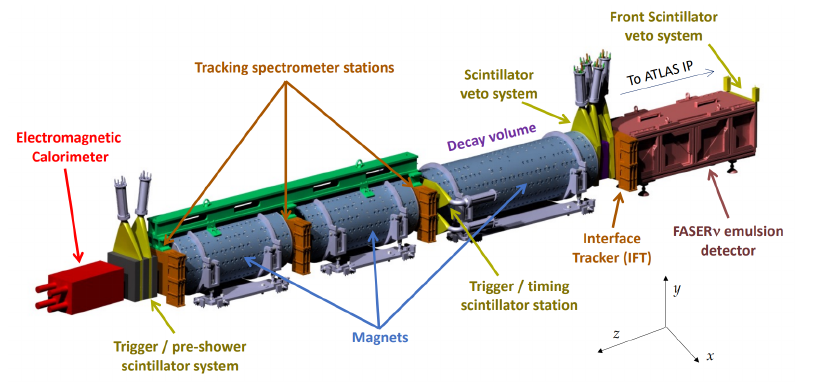
Figure 3. Diagram of FASER and FASER ν components [1].